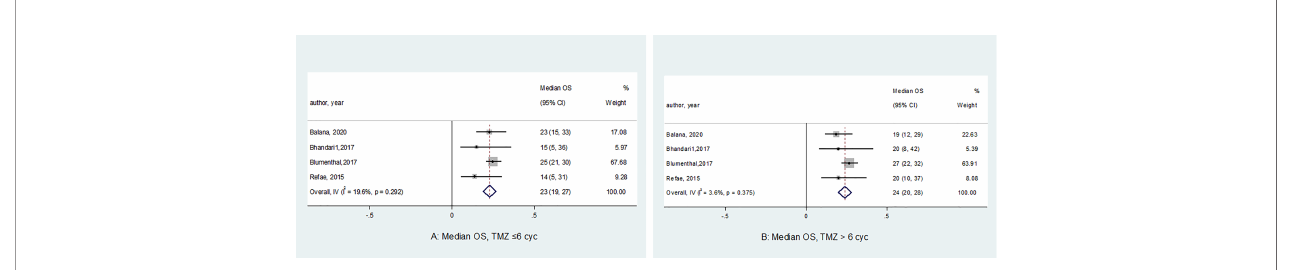
FIGURE 3 | Forest plots of the median overall survival (OS) according to the number of cycles of adjuvant temozolomide ( P = 0.99). The horizontal line of the diamond summary represents the average 95% CI. The statistical heterogeneity between studies was assessed using the I 2 test, which revealed homogeneity in the results (OS in the std-TMZ, I 2 = 19.6%, P = 0.29;and OS in the ext-TMZ, I 2 = 3.6%, P =